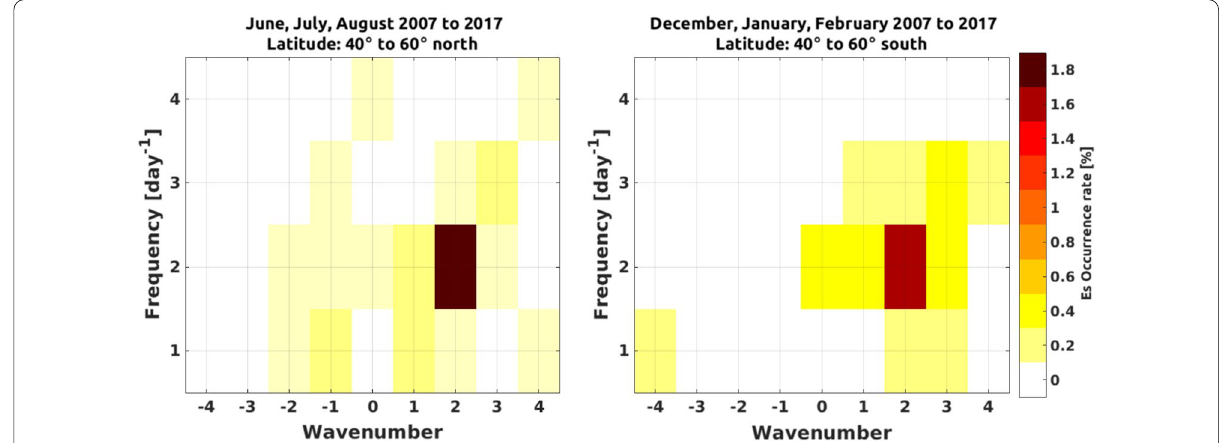
Fig. 4 Lunar tidal spectra of mid‑latitude EsOR during northern hemisphere summer (left) and southern hemisphere summer